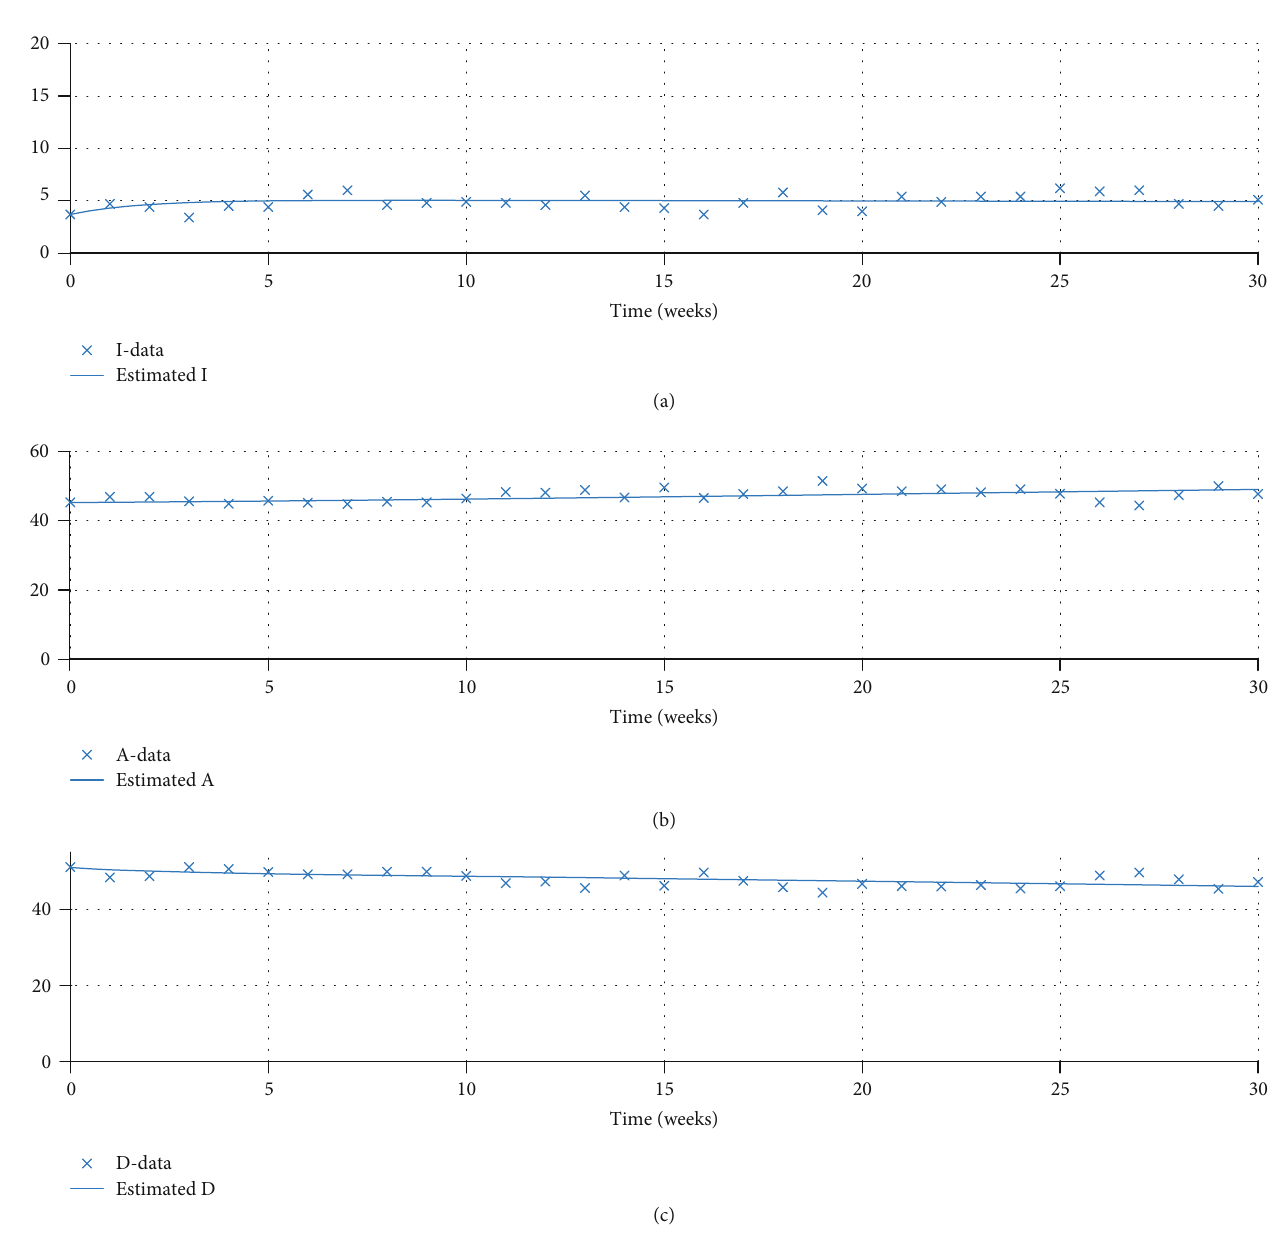
Figure 3: The Agree-Disagree model fi ts for the poll results data within 30 weeks. (a) The solid line depicts the model output for I , while the crosses show the indi ff erent individuals from data. (b) The solid line depicts the model output for A , while the crosses show the Agree individuals from data. (c) The solid line depicts the model output for D , while the crosses show the Disagree individuals from